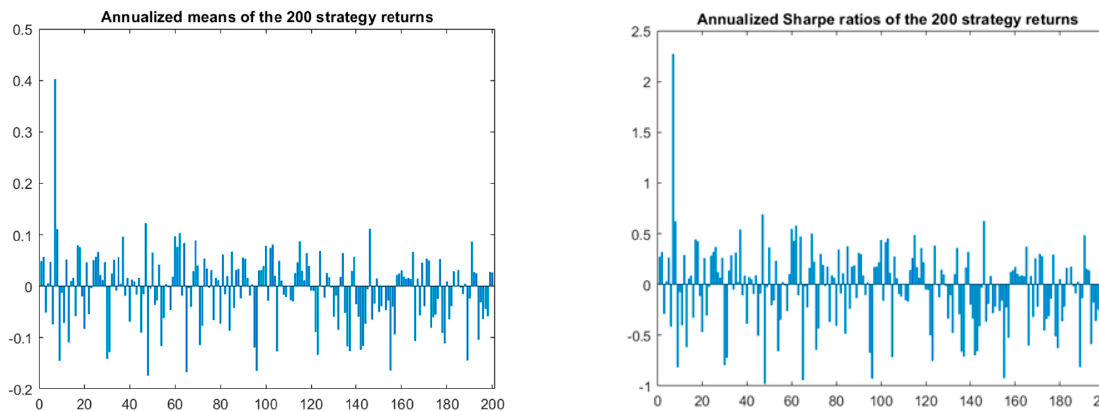
Figure 18. The modified annualized mean returns and Sharpe ratios of the 200 strategies.